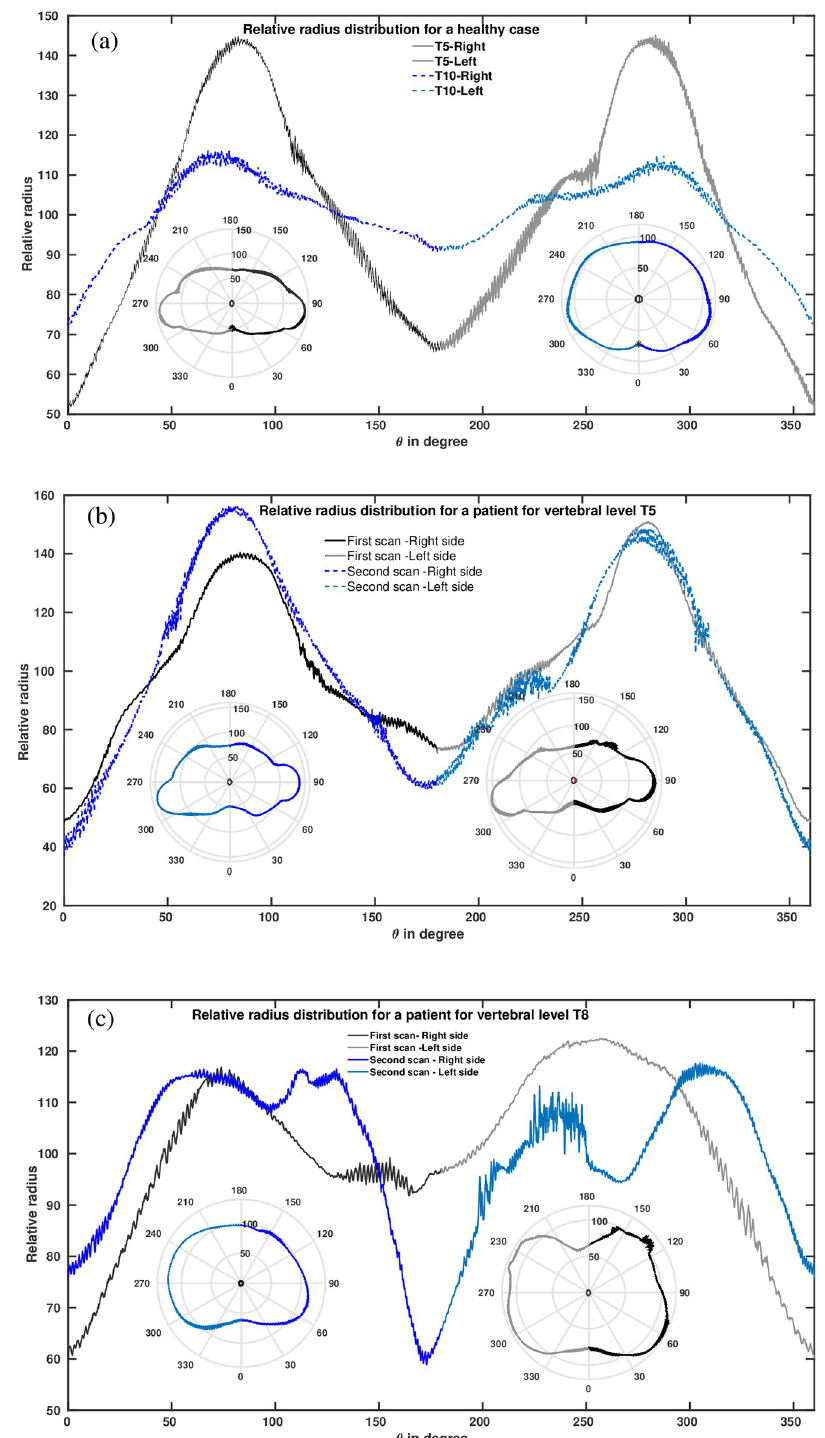
Fig 3. Angular distributions of example slices. (a) Examples of angular distribution from the transverse torso contours in polar and in linear coordinate, for the example cases extracted at two different vertebral levels in case of a healthy person. The black and gray lines are at the T5 level, the blue and light blue are from the same person at the T10 level. (b) Examples of angular distribution from the transverse torso contours in polar coordinates and also in linear coordinates, at the T5 vertical level in case of a person with scoliosis. The black and gray lines are from the person at the T5 level during her first scan. The blue and light blue from the same person but during a follow-up check. (c) The same as (b) but for the level of T8. The insets at all the subplots show the corresponding contours in polar coordinates.